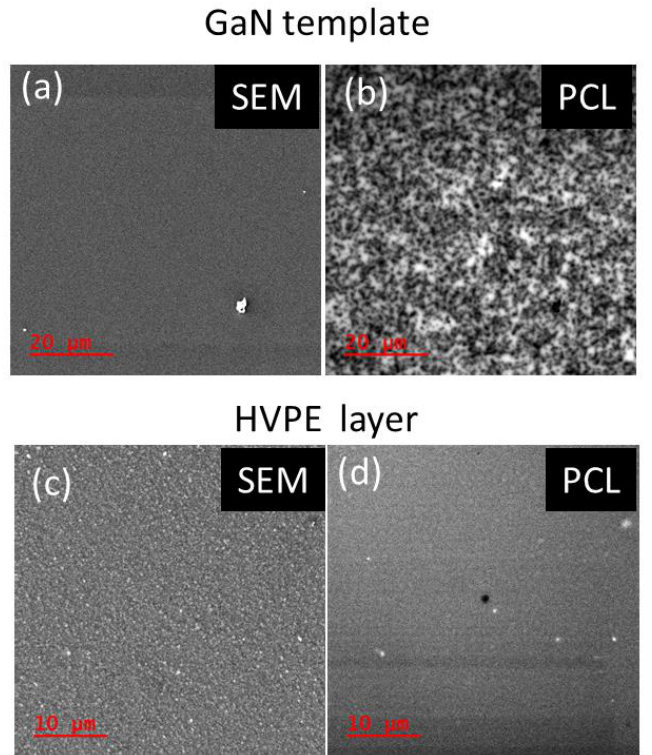
Figure 10. ( a ) SEM and ( b ) panchromatic CL images for the GaN template. ( c ) SEM and ( d ) panchro- matic CL images for the InGaN layer grown with plasma-activated ammonia at T g = 620 °C with HCl flow of 5 mL/min and at the indium melt temperature of 320 °C.